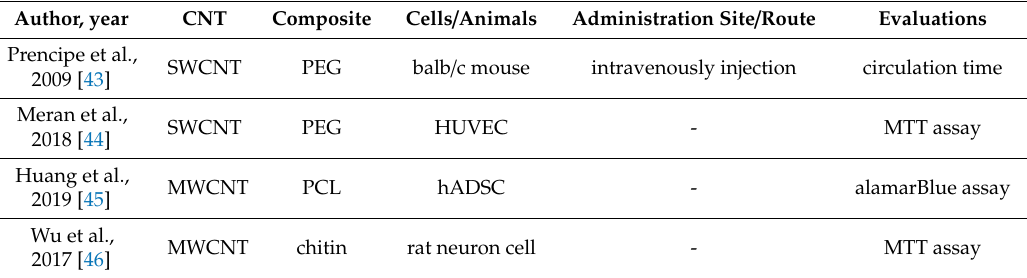
Table 3. Biocompatibility testing of CNT Composites.